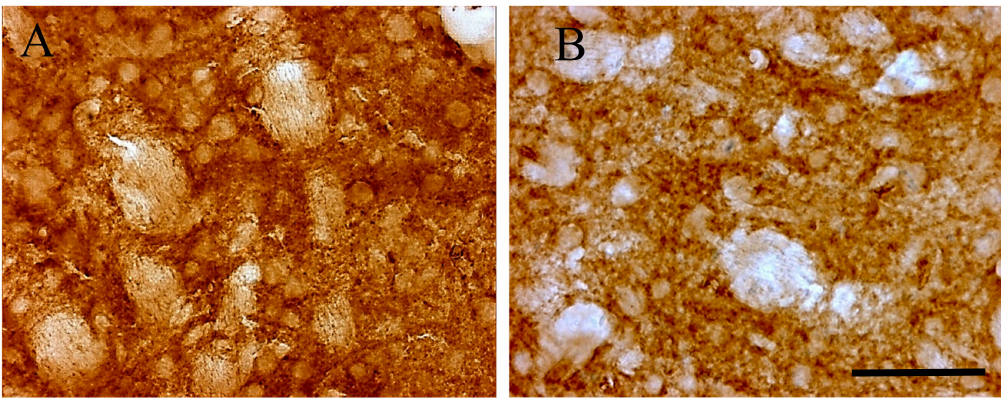
Figure 2. Representative microphotographs of D2 receptor immune-histochemistry in control Tor1a +/+ ( A ), and mutant Tor1a +/ − knock-out ( B ) mice. The brown reaction product is clustered around neuronal bodies and di ff used in the neuropil. Scale bar in B = 100 µ